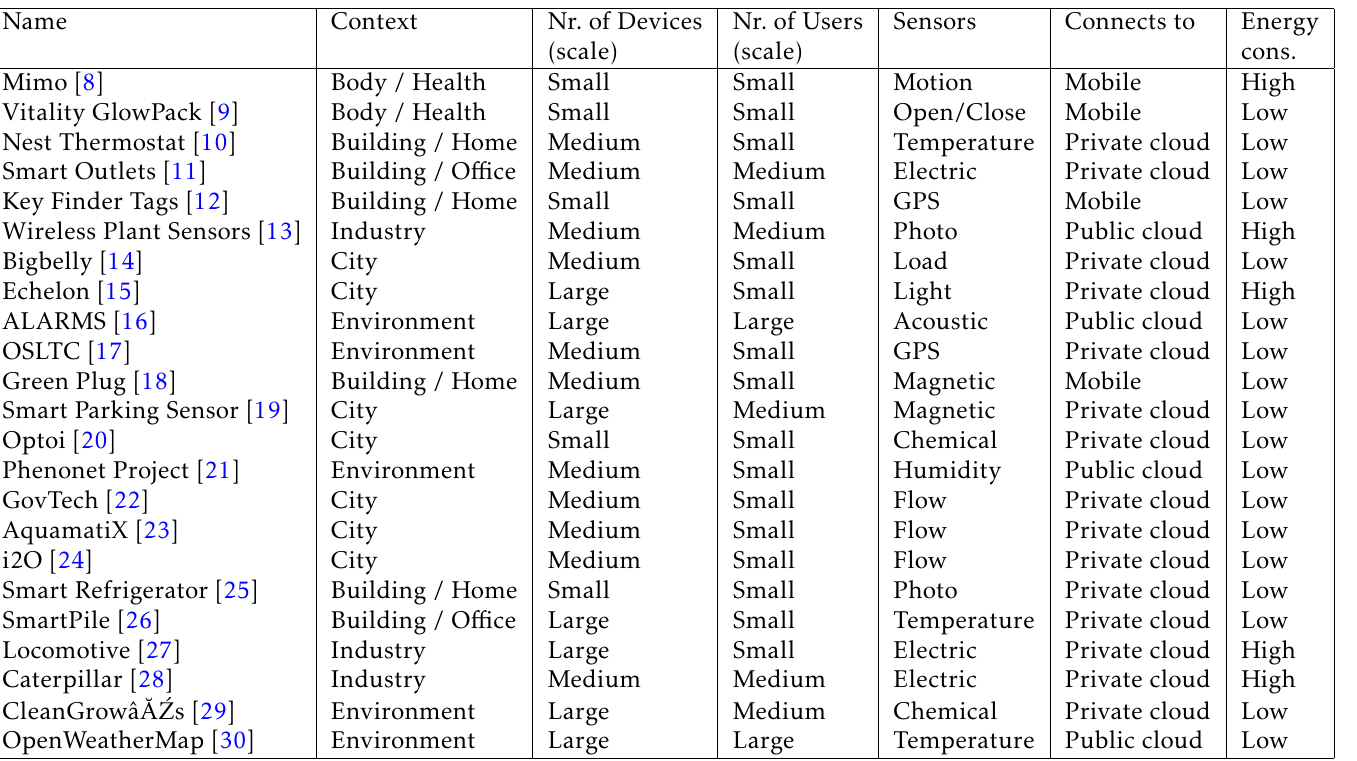
Table 1. Comparison table of IoT Use Cases - Part I